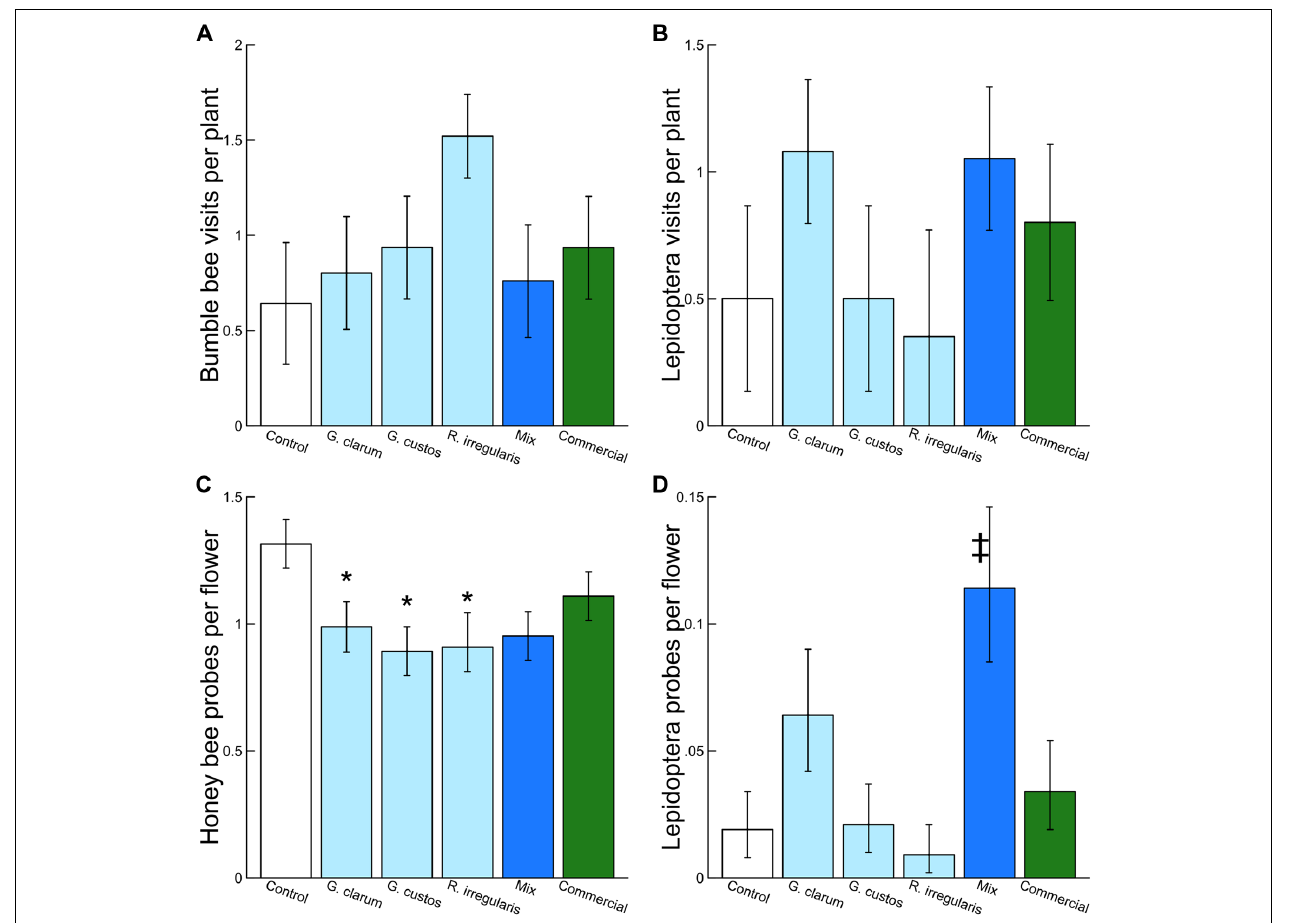
contrasts between non-mycorrhizal control and each single species inoculum ( G. clarum, G. custos, R. irregularis, and commercial). Double dagger indicates significant difference based on a priori contrast between the mixed inoculum and its component single-species inocula.